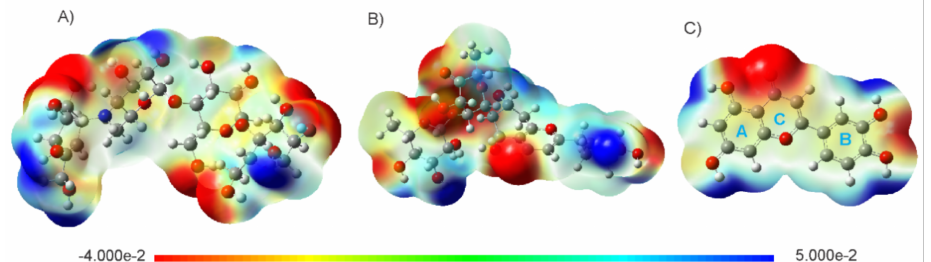
Figure 3. Electrostatic potential mapped on the electron density surface for ( A ) acarbose (ACA), ( B ) maysin (MAY) and ( C ) luteolin (LUT) calculated at the M06/6-31G(d) level of theory. The color range represents values from − 4.000 × 10 − 2 to 5.000 × 10 − 2 : blue = hydrogen donor zones and red = hydrogen acceptor